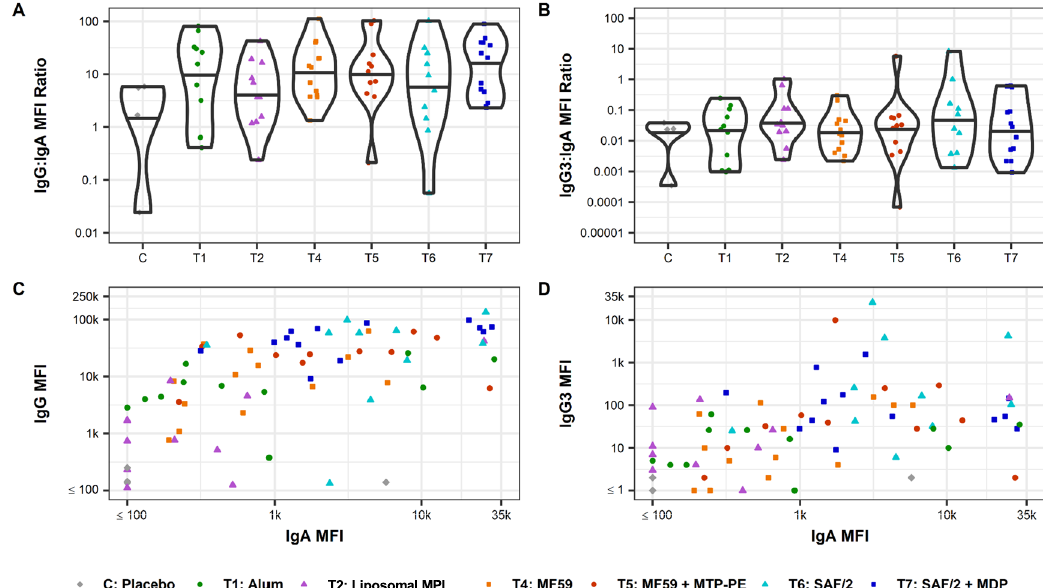
Fig. 5 Relative differences in induction of desirable versus undesirable antibody types. Ratio of MFI determined by Fc Array of SF-2 gp120- speci fi c antibodies raised 2 weeks past fi nal vaccination for subclass IgG over IgA ( A ) and IgG3 over IgA ( B ). Individual vaccine recipients are indicated by dots, and violin plots present group distributions, with median values indicated with a bar ( A , B ). Scatterplots of MFI values determined by Fc array indicate IgA vs IgG ( C ) or IgA vs IgG3 ( D ) elicited against SF-2 at 2 weeks past fi nal vaccination. Dots represent individual vaccine recipients; color and shape indicate study